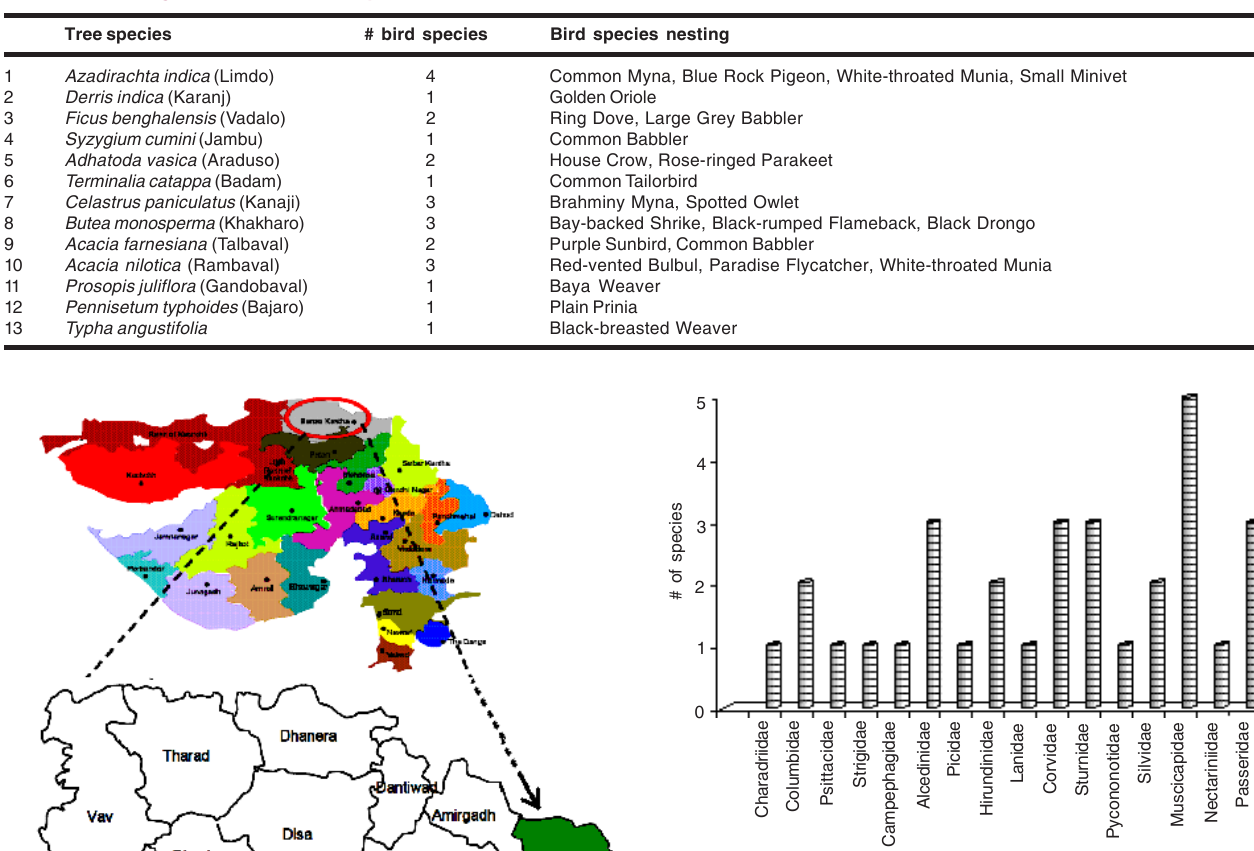
Table 4. Nesting of different bird species observed on various trees